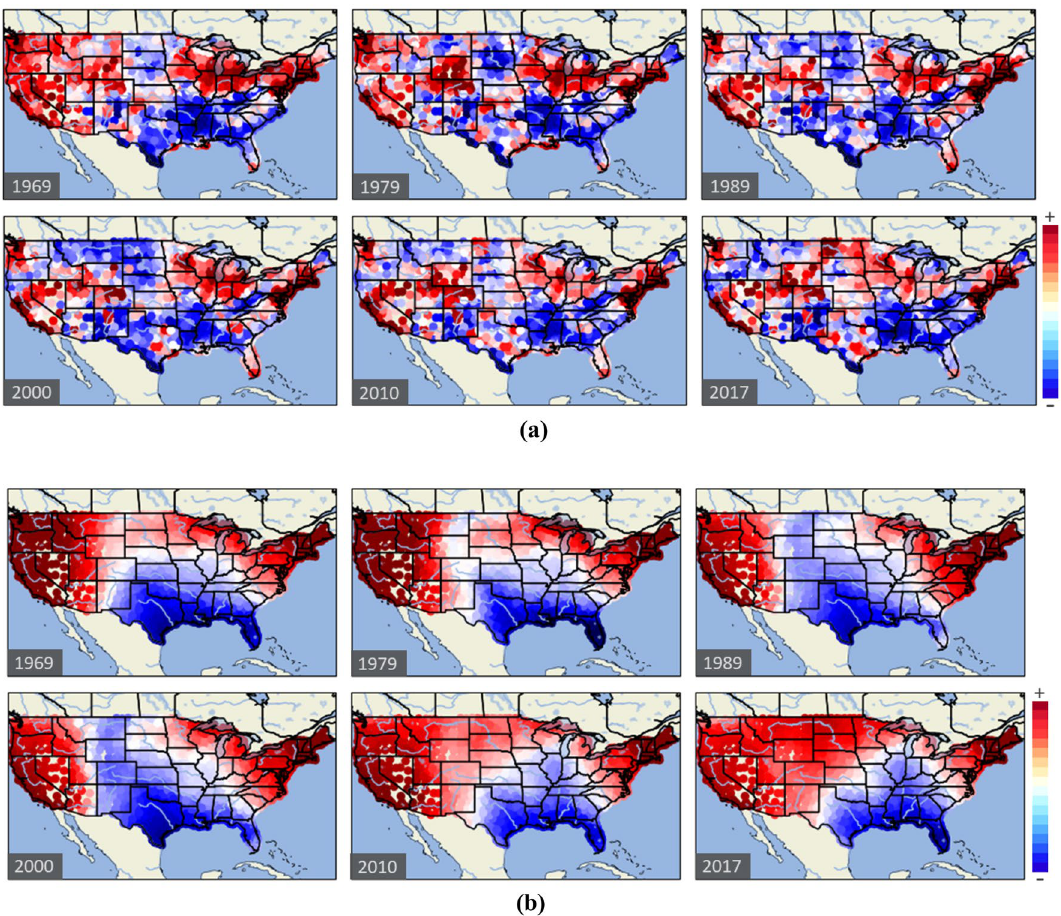
Figure 7. Income composition in the United States mainland over time by considering different aggregation levels: ( a ) 100 km and ( b ) 1000 km. Six years are represented: 1969, 1979, 1989, 2000, 2010, and 2017. Regions below national average income are shown in blue, while regions above national average income are shown in red. White-colored regions that emerge as gaps show regions with similar values to the national average. This figure was generated in Python using the library